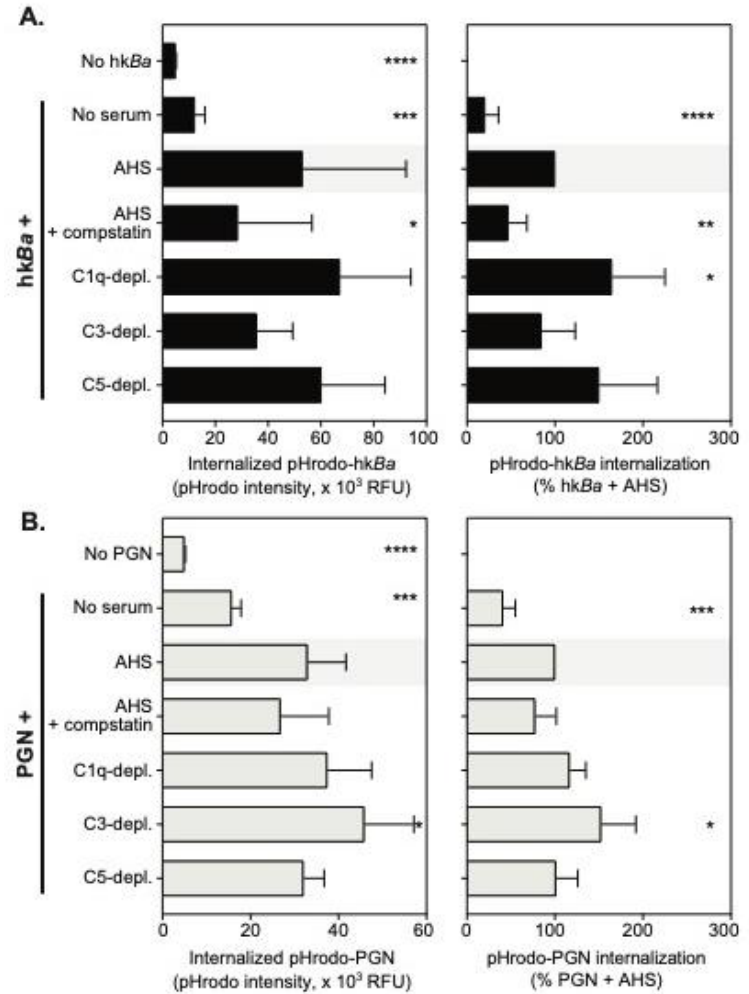
Figure 3. Quantitation of pHrodo-hk Ba ( A ) and / or pHrodo-PGN ( B ) internalization by neutrophils in the presence of compstatin, a C3 convertase inhibitor, or the immunodepletion of complement factors. Data are shown as mean ± SD of 6 independent donors, and depict pHrodo fluorescence intensity after the internalization of labeled bacteria or PGN (left panels) and normalized changes in endocytosed pHrodo-labeled particles compared to bacteria or PGN uptake in the presence of autologous serum (AHS), which was considered 100% (right panels). Statistically significant di ff erences compared to pHodo uptake in the autologous serum (AHS, shaded) are depicted graphically (* p < 0.05; ** p < 0.01; *** p < 0.001; **** p < 0.0001), and were computed by repeated measures one-way ANOVA with Holm–Sidak’s multiple comparisons test (left panels), or one sample t test compared to the normalized value (right panels).